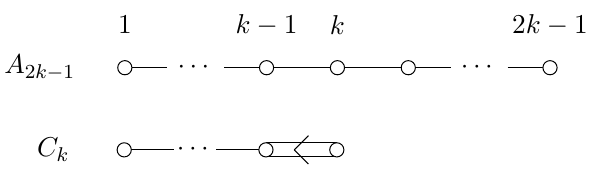
Figure 1 . Dynkin diagram A 2 k − 1 (Lie algebra su ( N = 2 k ) ) has a Z 2 outer automorphism, which flips the order of its nodes. Folding it by average yields the Dynkin diagram C its C -invariant subalgebra sp (2 k ) . A